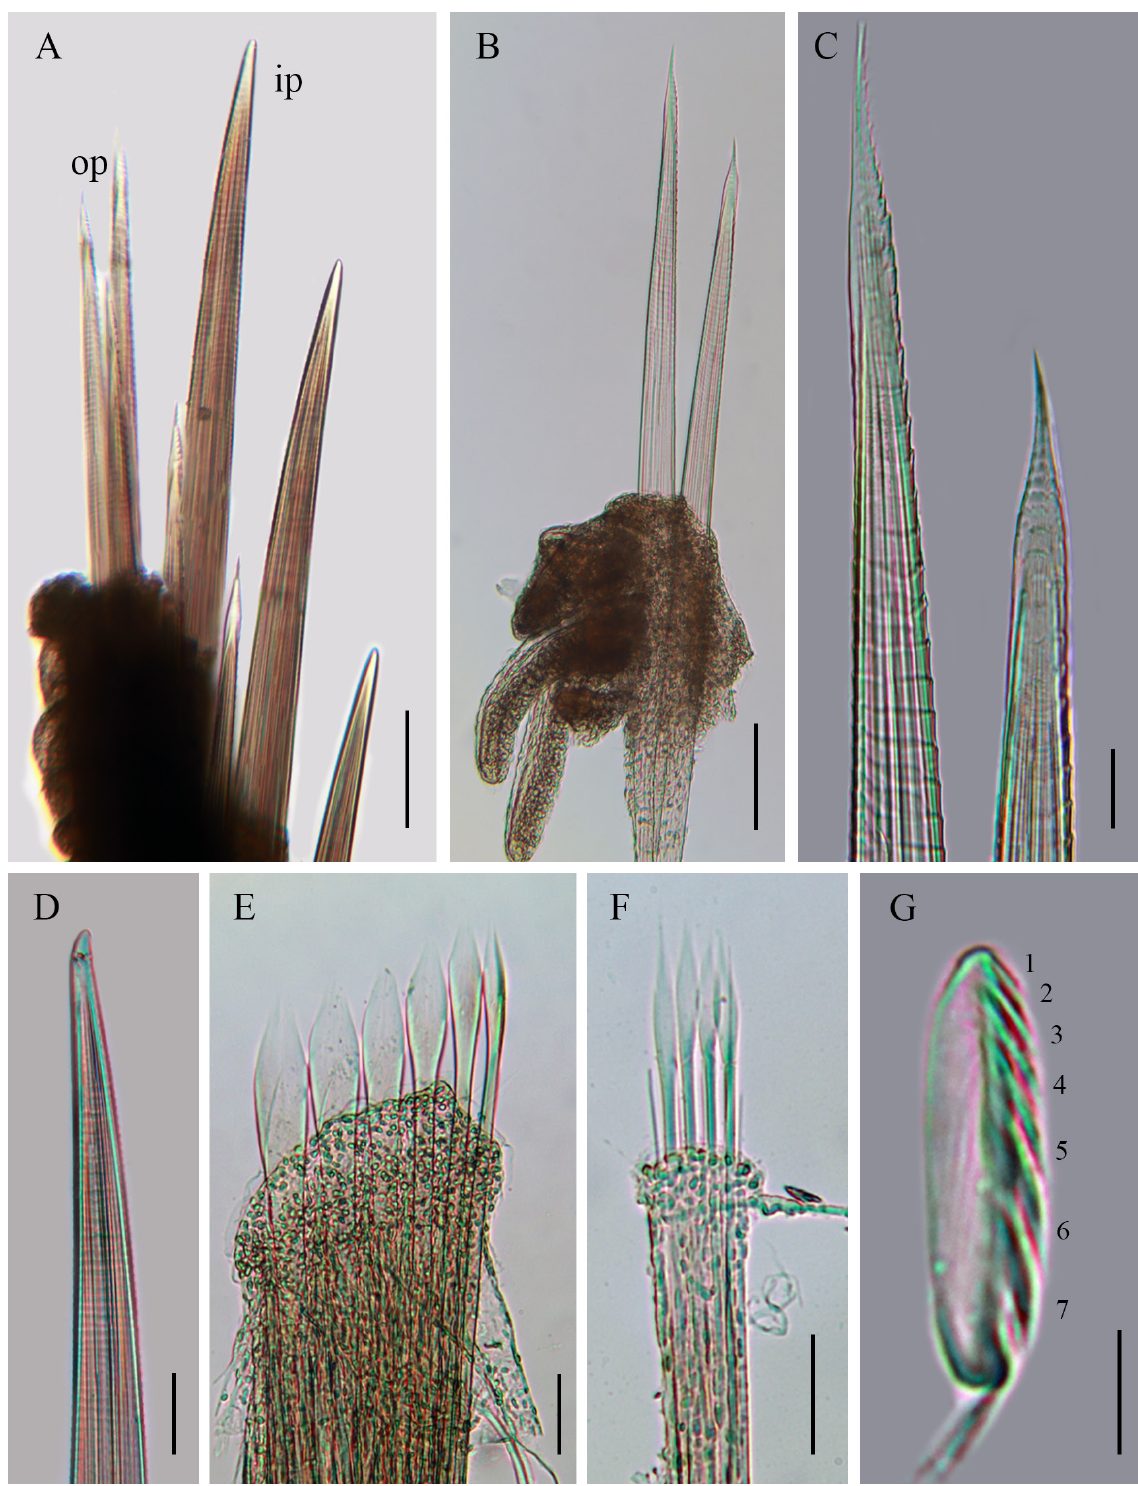
Fig. 2. Lygdamis pechi sp. nov., holotype (ECOSUR-302). A . Opercular paleae. B . Outer paleae. C . Detail of the outer paleae tips. D . Inner palea. E . Parathoracic notochaetae. F . Parathoracic neurochaetae. G . Abdominal uncini. Abbreviations: op = outer paleae; ip = inner paleae. Numbers indicate the rows of teeth. Scale bars: A–B = 100 µm; C = 20 µm; D–F = 50 µm; G = 10